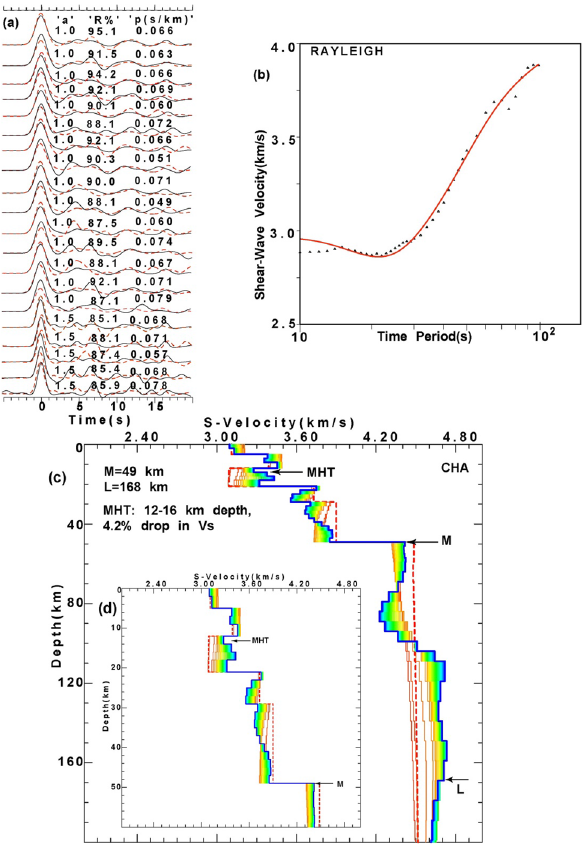
Figure 3. Results of joint inversion of P-RFs and fundamental mode Rayleigh wave group velocity dispersion data at CHA station, ( a ) showing good agreement between observed (black line) and inverted (red line) radial RFs with a = 1.0 and 1.5, for different horizontal slowness (S, in s/km). Here, “a” and “R%” represent Gaussian width factor (used for estimating RF) and agreement (in %) between observed and inverted RFs, respectively. ( b ) Correlation between observed and inverted dispersion curve of Rayleigh waves. ( c ) Inverted shear velocity models showing Moho (M) and LAB (L) depth estimates. Different colors represent different Versus models used for the joint inversion. The initial shear velocity model is shown by a thick red dotted line, while the final shear velocity model is shown by a thick blue line, and ( d ) zoomed portion of figure ( c ) showing only crustal Versus model. Furthermore, MHT, M, and L mark the thickness of the Main Himalayan Thrust in km, Moho depths in km and lithospheric thickness in km,